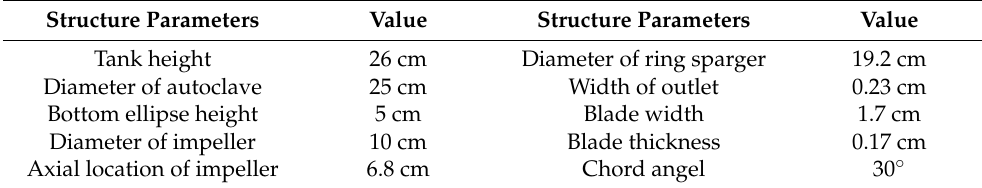
Figure 1. ( a ) Computational domain; ( b ) generated mesh; ( c ) pitched blade turbine; ( d ) generated mesh of impeller. Table 1. Structural parameters of autoclave.